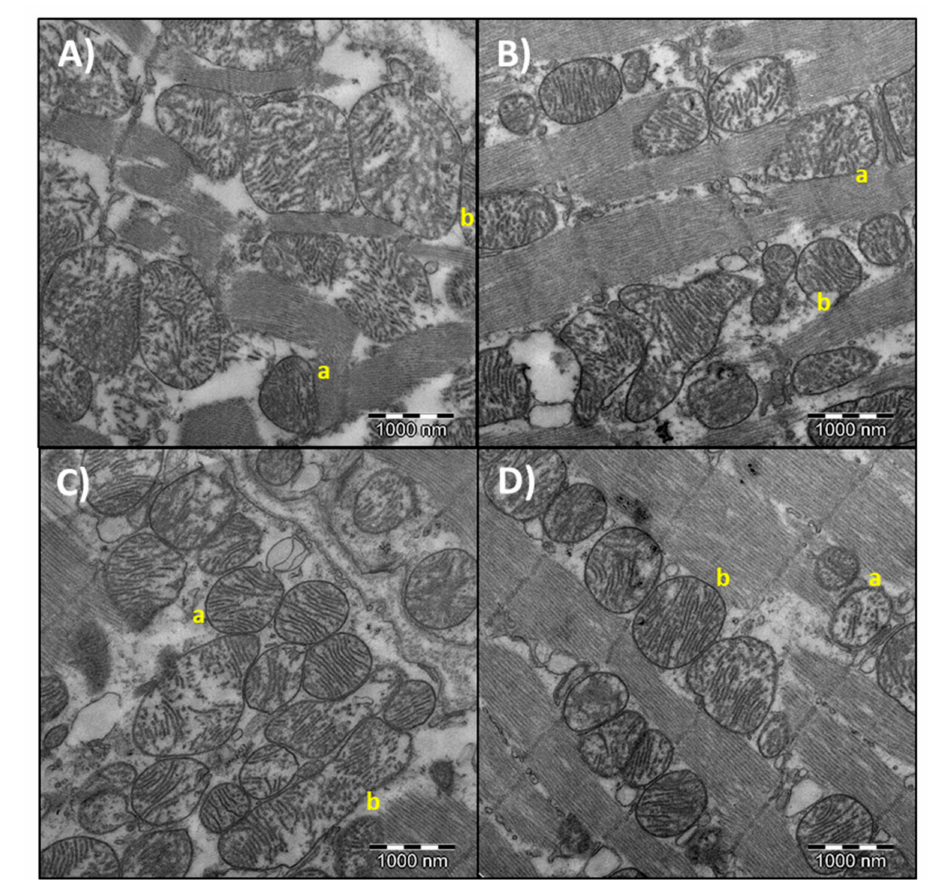
Figure 3. Representative images of mitochondrial ultrastructure in the heart of 6 and 24-month-old rats. ( A ) representative image of mitochondria with low (a) or high (b) area and perimeter. ( B ) representative image of mitochondria with low (a) or high (b) circularity. ( C ) representative image of mitochondria with low (a) or high (b) aspect ratio. ( D ) representative image of mitochondria with low (a) or high (b)